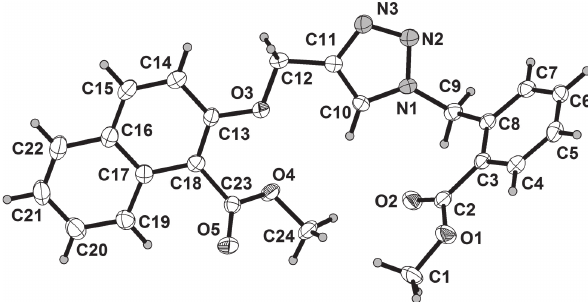
Table 1: Crystal collection and handling.